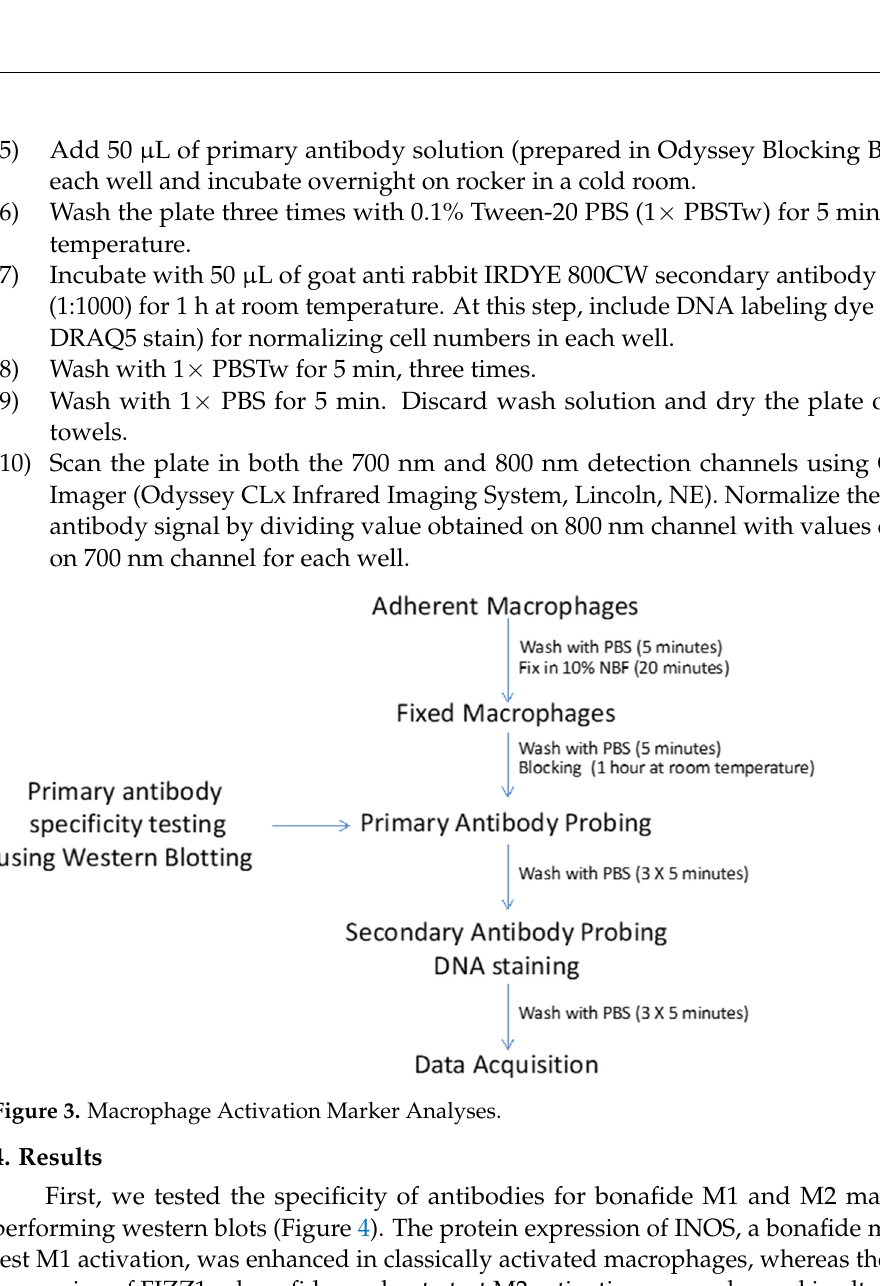
Figure 5. In Cell Western analyses for activation-specific markers in Naïve (M0), M1-activated (CAM), and M2-activated (AAM) BMDMs. N = 3, ANOVA, *** p < 0.001. Error bars represent stand- ard error of the mean (SEM). Antibody specificity for other activation markers (ARG1, COX1, MMP12, ALOX12/15, and YM1/2) was confirmed using western blot (data not shown). Finally, ac- tivated macrophages were interrogated for the expression levels of selective activation markers (Figure 6).